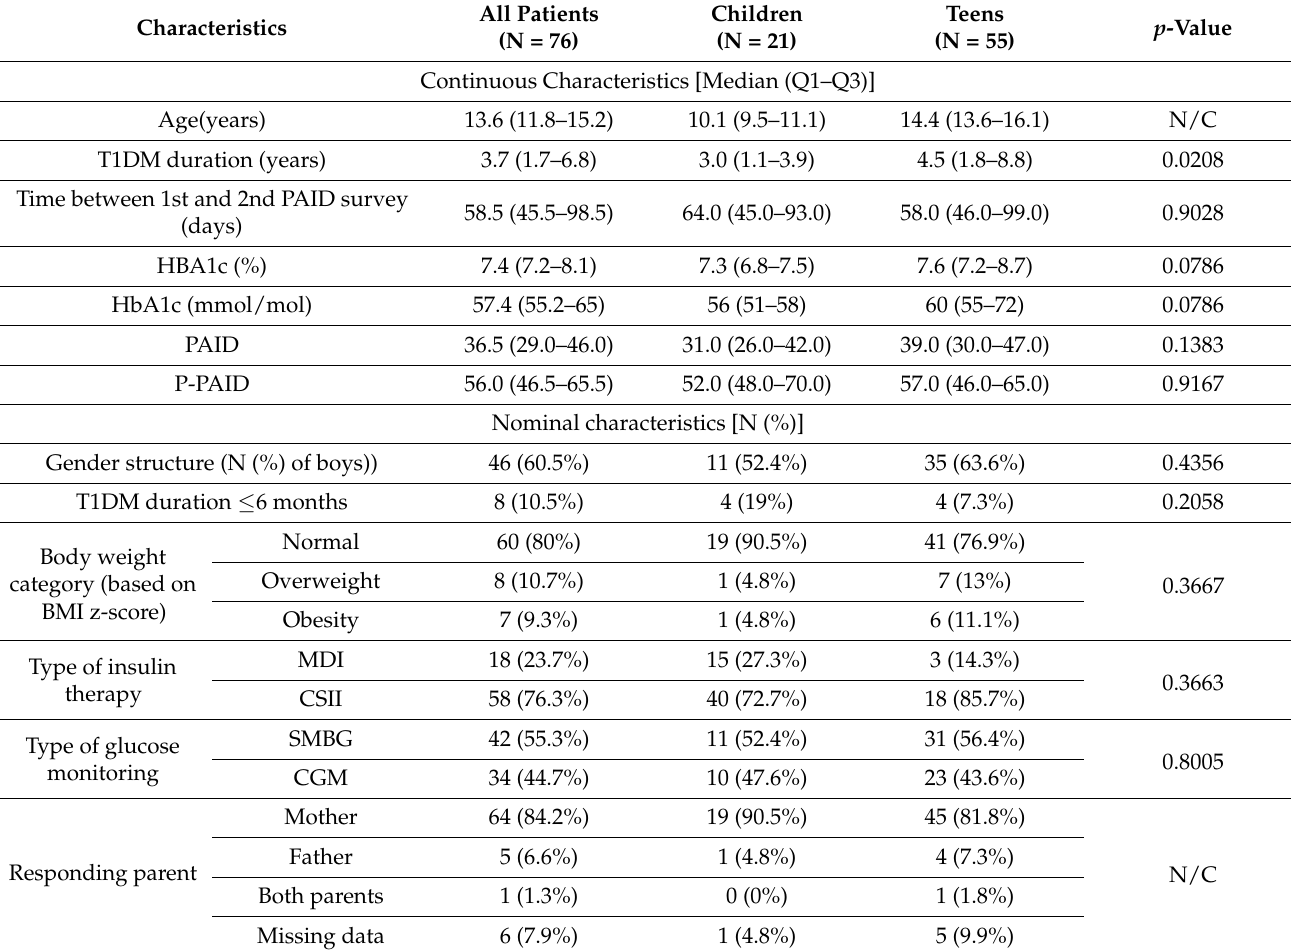
Table 1. Study group